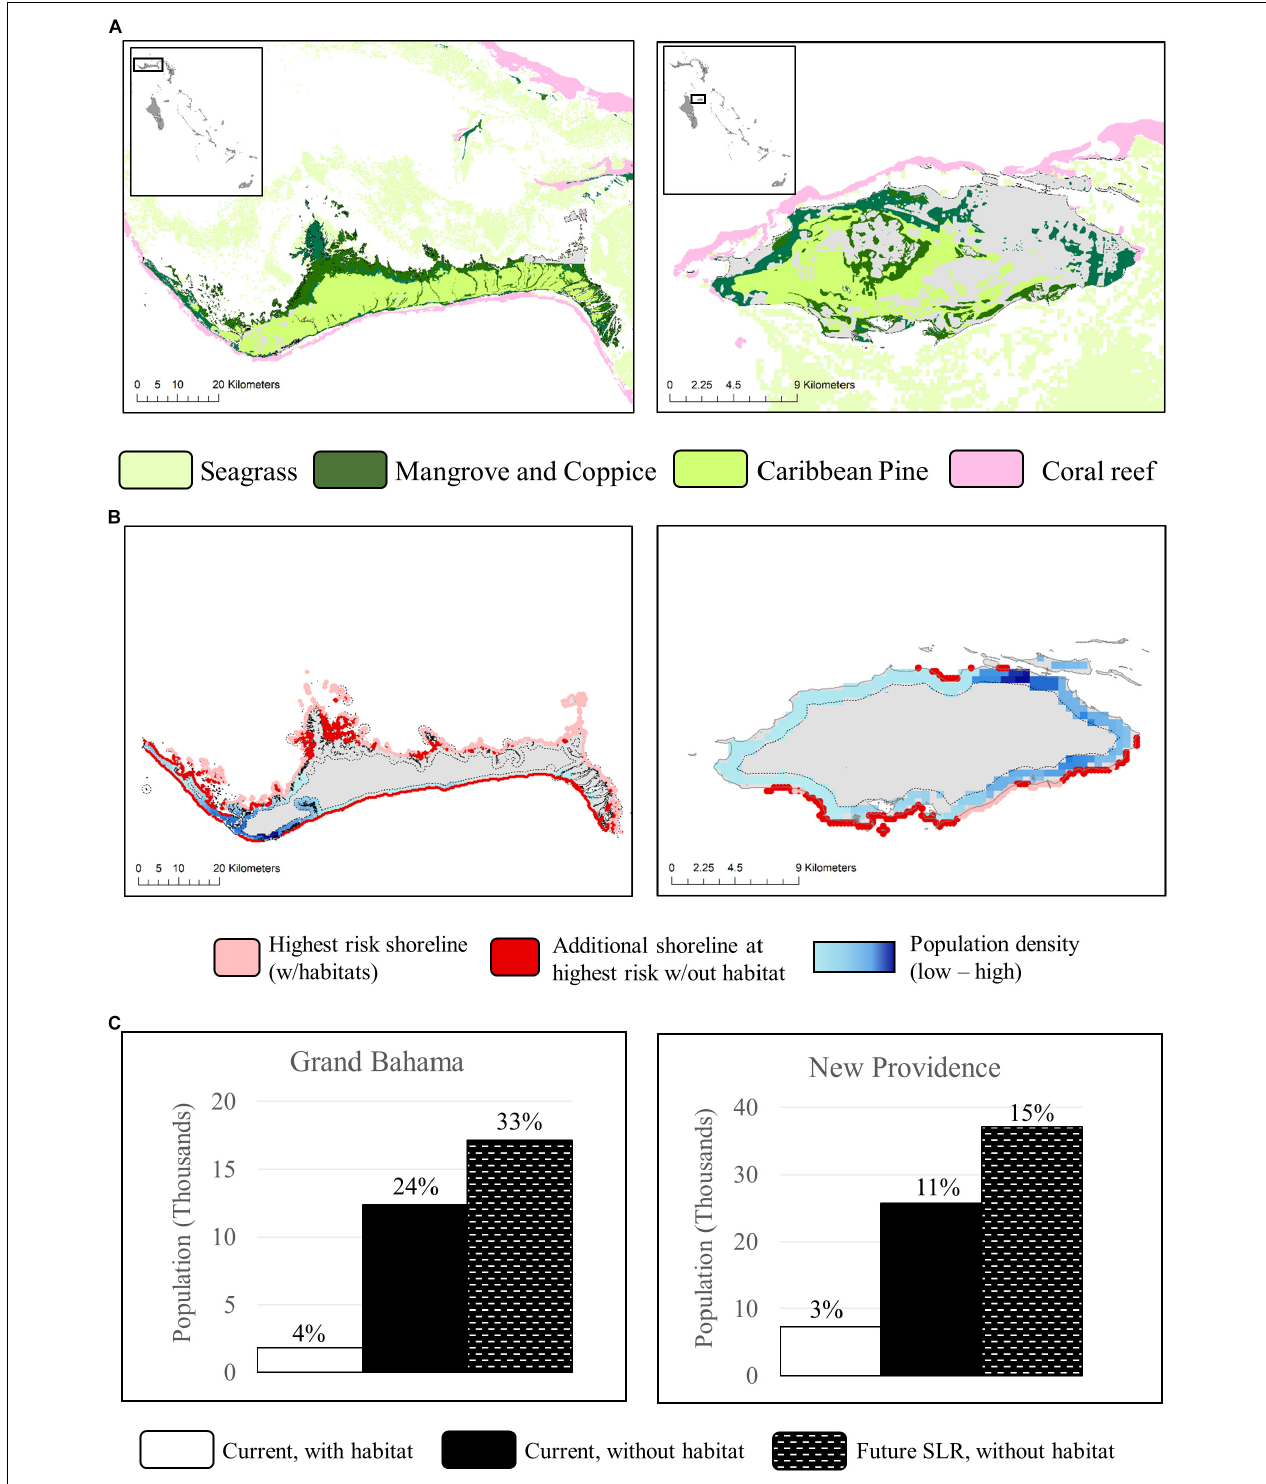
FIGURE 6 | Coastal and marine ecosystems on Grand Bahama and New Providence Islands (A) provide protection for people who, if those habitats were lost, would be living along the highest risk shoreline (B) . Population within a 1km inland coastal hazard zone is indicated with a dashed line. Bar charts in (C) show the total number of people and the percentage of the total island population at highest risk in each scenario (with habitat and current sea-levels, without habitat and current sea-levels, and without habitat and SLR).